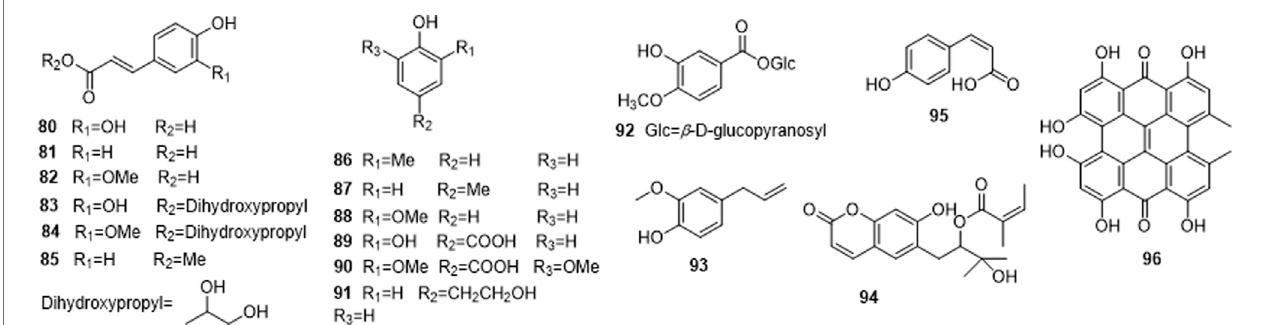
FIGURE 4 | Structures of other phenolics (80 – 96) form P. mume .